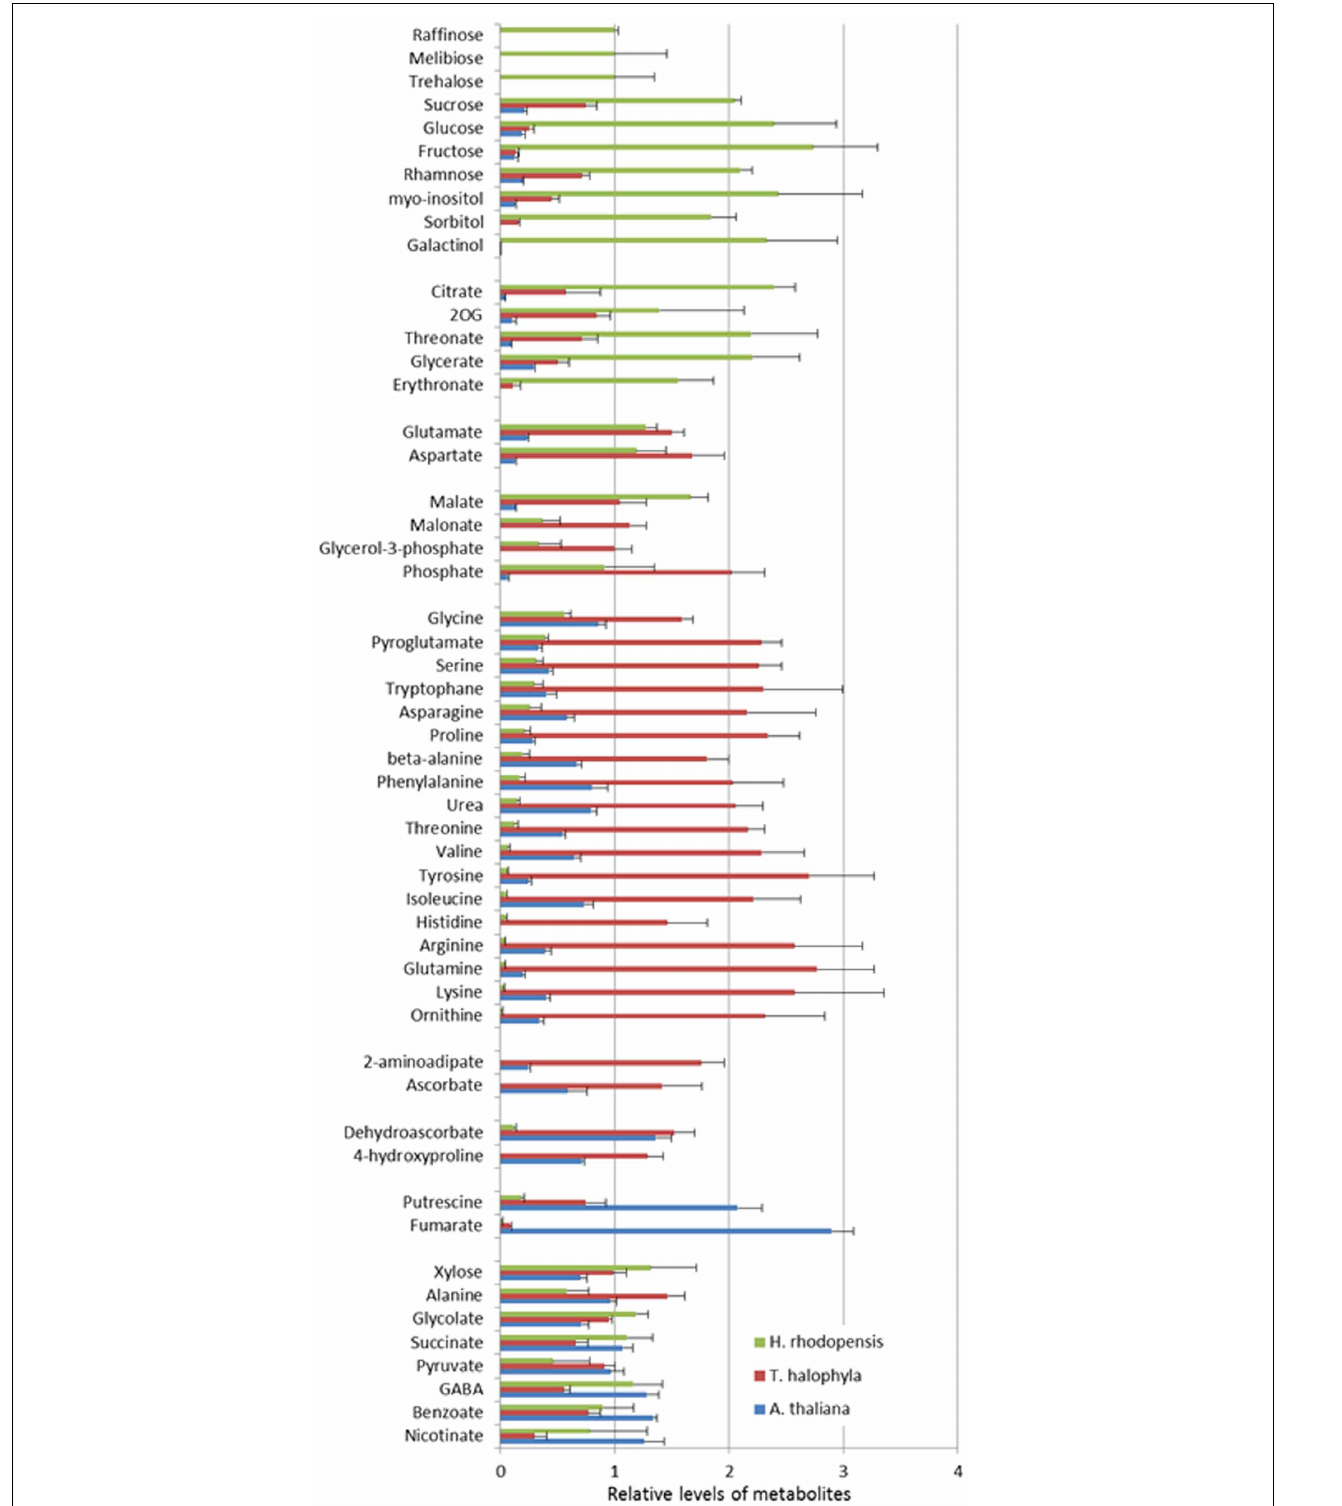
FIGURE 4 | Comparison of metabolite levels in A. thaliana (blue), T. halophyla (red) and H. rhodopensis (green) under pre-stress condition. Metabolite levels are normalized by the means of all samples and presented as mean + s.e.m. of six biological replicates.